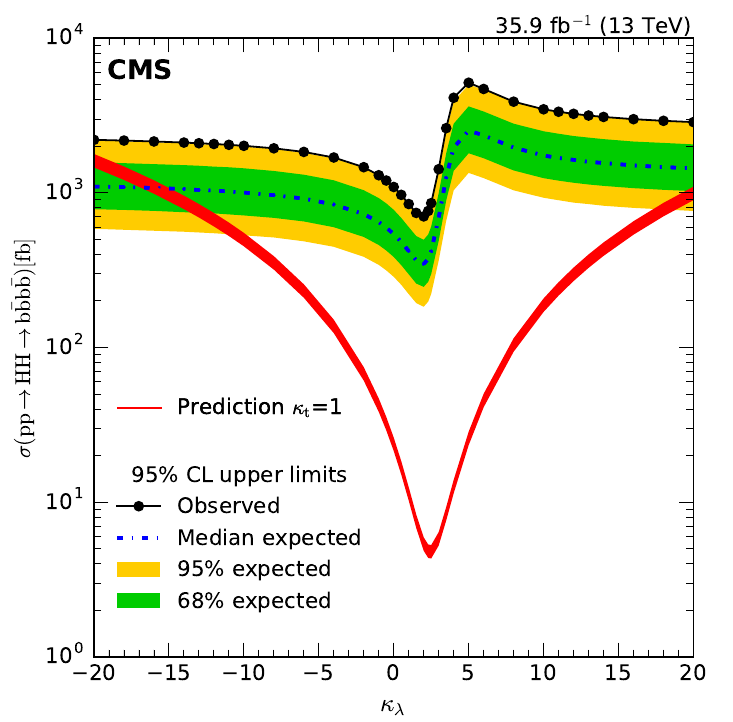
Figure 10 . 95% CL cross section limits on (cid:27) (pp ! HH ! bbbb) for values of (cid:20) (cid:21) in the [-20,20] range, assuming (cid:20) t = 1; the theoretical prediction with (cid:20) t = 1 is also shown. HH signal. Limits at 95% con(cid:12)dence level on the HH production cross section times